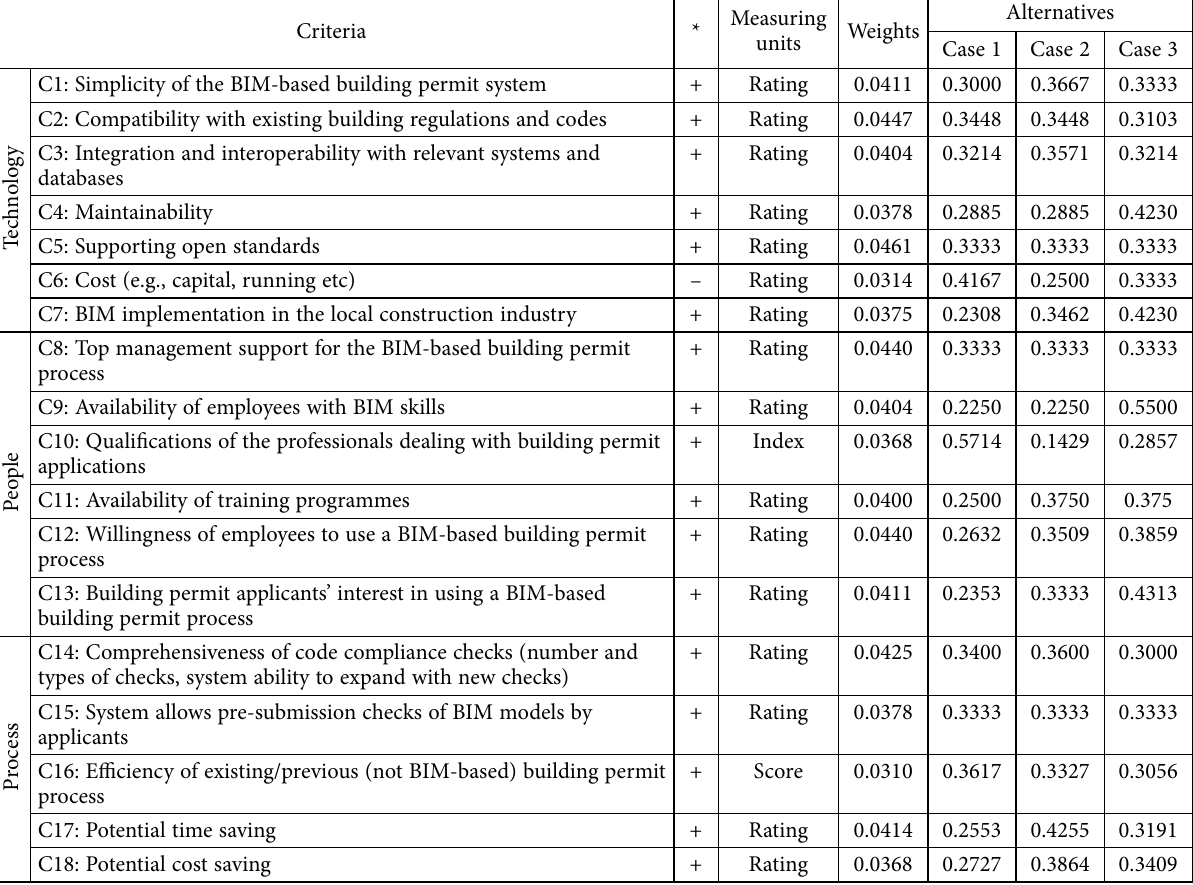
Table 8. Readiness assessment for BIM-based building permit